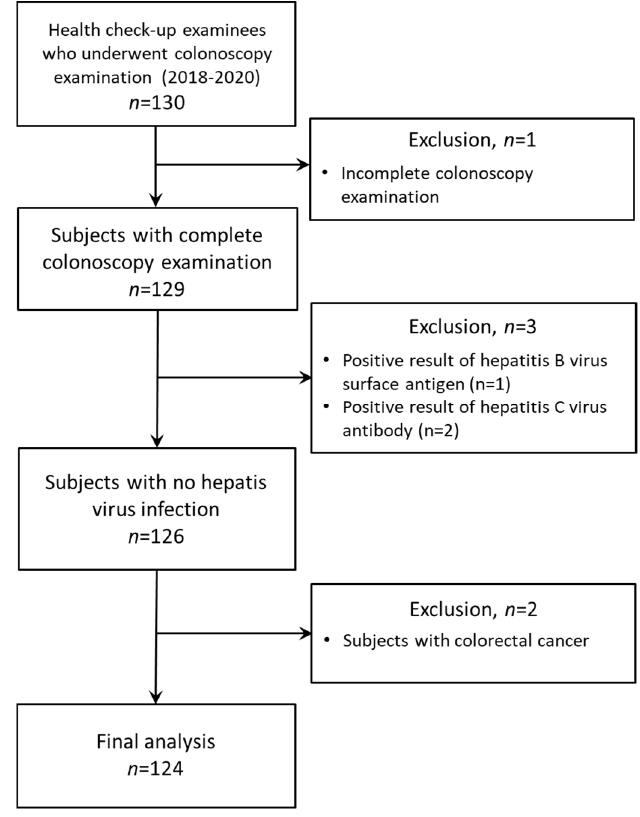
Figure 4. A flow chart for study